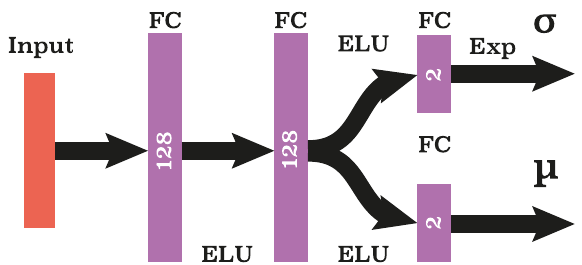
Figure 6. The architecture of the neural network for the action